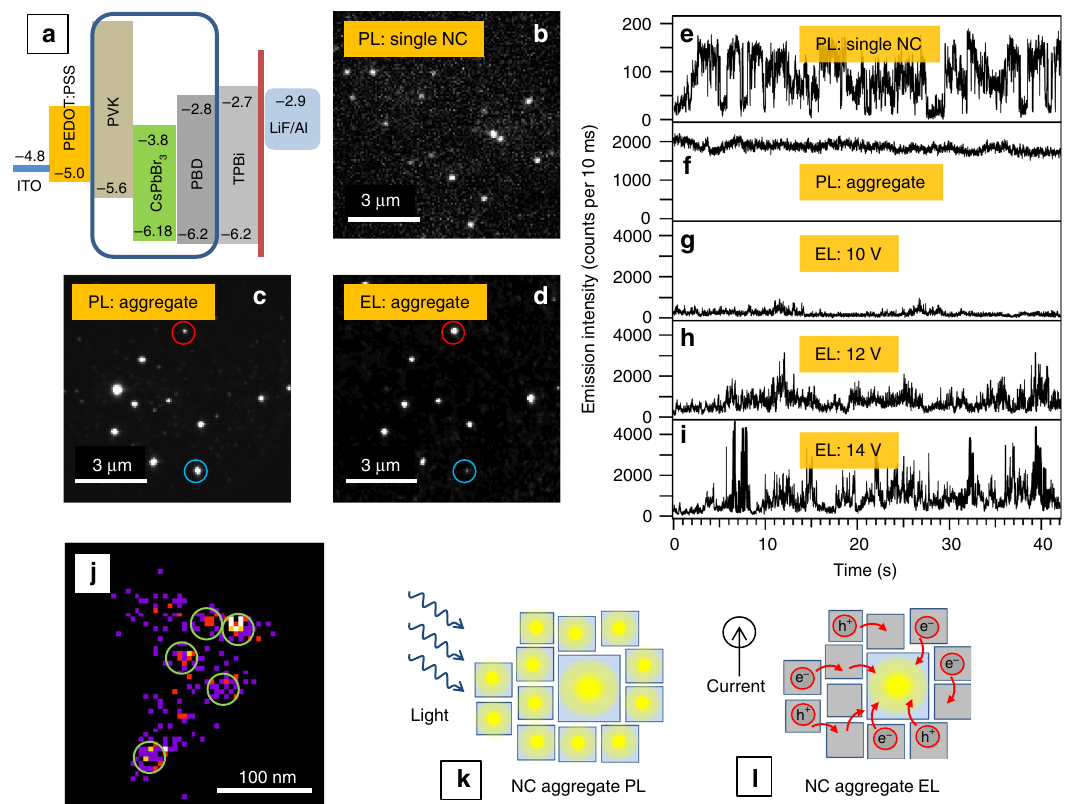
Fig. 1 Imaging and blinking of NC aggregates in PL and EL. a Scheme of the EL device structure, together with the relevant energy levels. b Microscopic PL image of single NCs of CsPbBr 3 in PVK matrix. c Microscopic PL image of aggregates of CsPbBr 3 NCs in EL device. d Microscopic EL image (at a bias of 14 V) of the same NCs aggregates as in c . In c and d , the blue circles denote an example of an aggregate which shows stronger PL, red circles an aggregate which shows stronger EL. e Intensity time trace of PL of single CsPbBr 3 NCs in PVK matrix. f Intensity time trace of PL of aggregates of CsPbBr 3 NCs in EL device; intensity time trace of EL of aggregates of CsPbBr 3 NCs at g 10; h 12; and i 14 V. j Super-resolution EL image obtained by analysis of a series of microscopic EL images of aggregates of CsPbBr 3 NCs at 14 V over the time of 60 s. k Schematic illustration of PL from an aggregate showing independent emission from individual NCs. l Schematic illustration of EL from an aggregate showing charge migration (red arrows) and emission from the largest NC which works as a